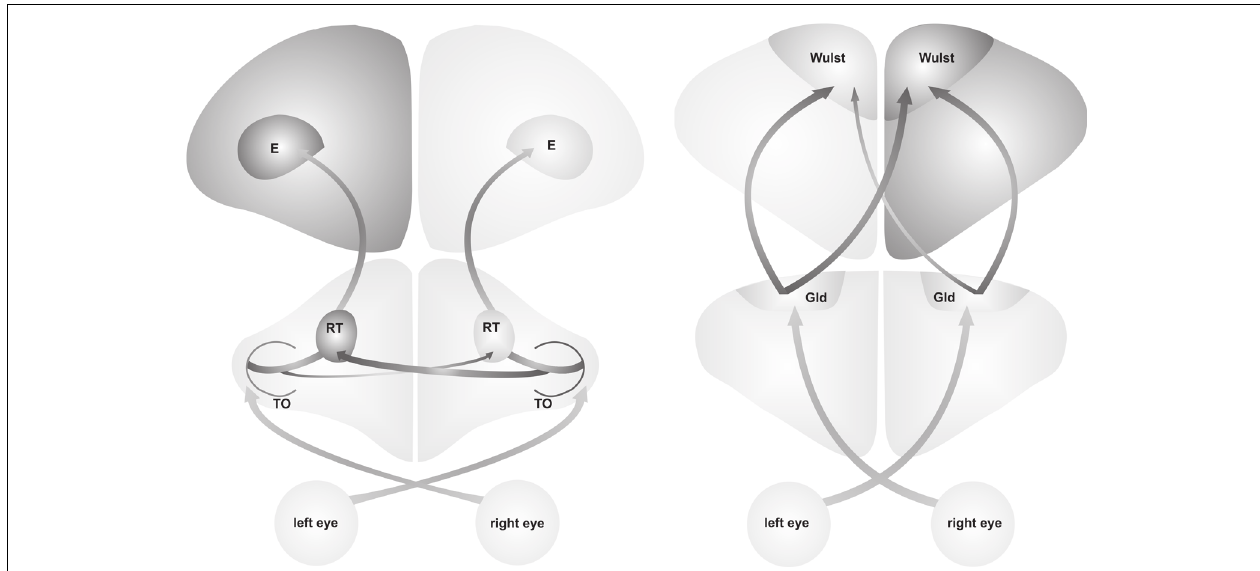
dorsalis (Gld) to the right visual Wulst are stronger than projections from the right Gld to the left visual Wulst. These projection asymmetries lead to higher bilateral input to the left hemisphere in pigeons and to the right hemisphere in pigeons (indicated by darker coloring). These anatomical asymmetries lead to a lateralized behavior in each species (E, entopallium).